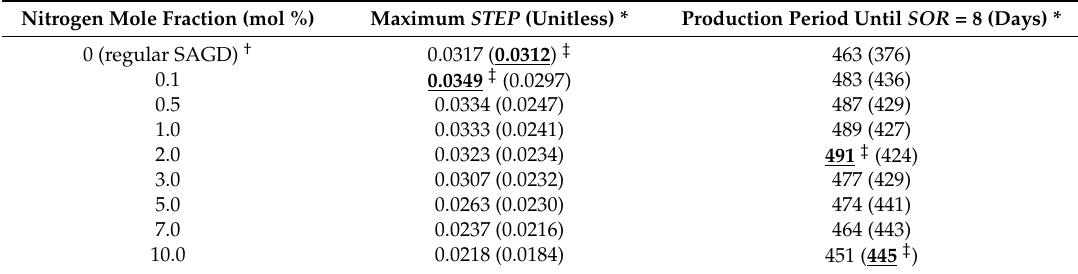
Table 4. Summary of the nitrogen mole fraction affecting the simple thermal efficiency parameter ( STEP ) and the production time until the steam to oil ratio ( SOR ) is